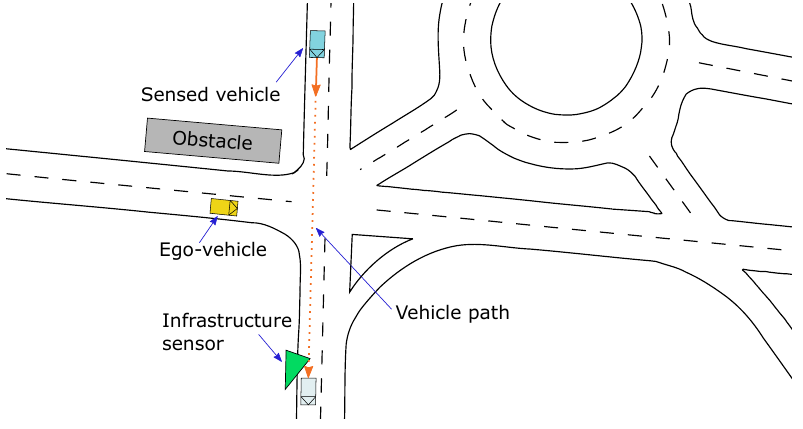
Figure 10. Dynamic obstacles